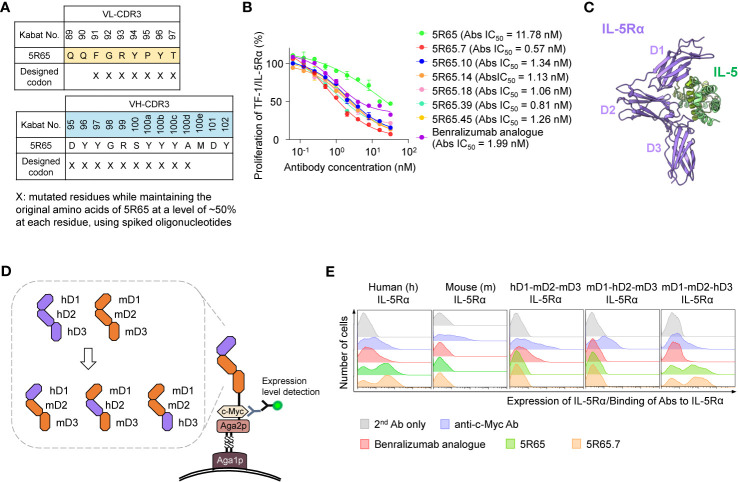
Engineering of 5R65 to generate a more potent Ab, 5R65.7, and domain level epitope mapping of anti–IL-5Rα Abs. (A) The scheme of yeast scFab library construction for VL-CDR3 and VH-CDR3 of the 5R65 Ab, where the indicated residues (X) were randomly mutated using spiked oligonucleotides designed to keep the original amino acids at each position of 5R65 at a frequency of approximately 50%. (B) IL-5Rα–blocking activity of the indicated anti–IL-5Rα Abs, as determined by the effect on the proliferation of TF-1/IL-5Rα cells after stimulation with rhIL-5 (80 pM) in the presence of Abs (0 to 32 nM) for 40 h. The absolute (Abs) IC50 values of the Abs are provided. Each point of the curve represents mean ± SD. (C) Overall structure of the human IL-5Rα–IL-5 complex (Protein Data Bank ID: 3QT2), where the three domains (D1, D2, and D3) within the extracellular regions of IL-5Rα are indicated. (D) The yeast surface display scheme for domain-swapped IL-5Rα variants, where the three extracellular domains of human IL-5Rα (hD1, hD2, or hD3) were replaced with the corresponding mIL-5Rα domain (mD1, mD2, or mD3). (E) Flow-cytometric analysis of yeast cell surface expression levels of the indicated wild-type IL-5Rα and domain-swapped IL-5Rα variants as well as binding activity of the indicated anti–IL-5Rα Abs (100 nM) toward the IL-5Rα variants. Representative histograms from three independent experiments are depicted.